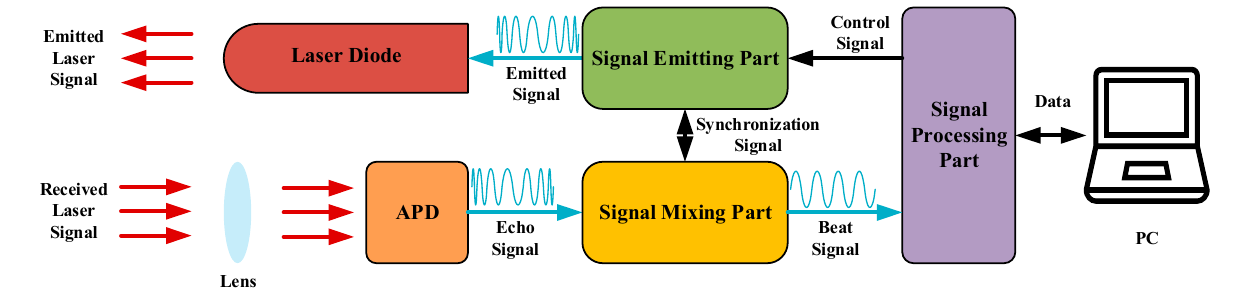
Figure 2. Scheme of FMCW laser ranging system.